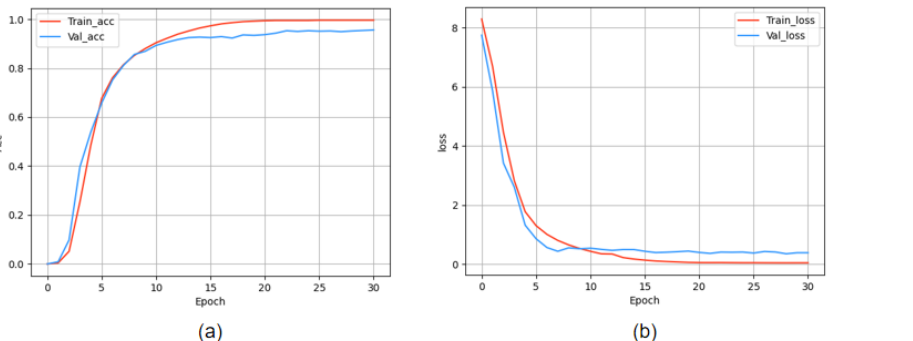
Figure 7. Training graph of accuracy and loss with the number of epochs. ( a ) Accuracy graph. Train_acc indicates the accuracy curve of the training set. Val_acc indicates the accuracy curve of the validation set. ( b ) Loss graph. Train_loss indicates the loss curve of the training set. Val_loss indicates the loss curve of the validation set.